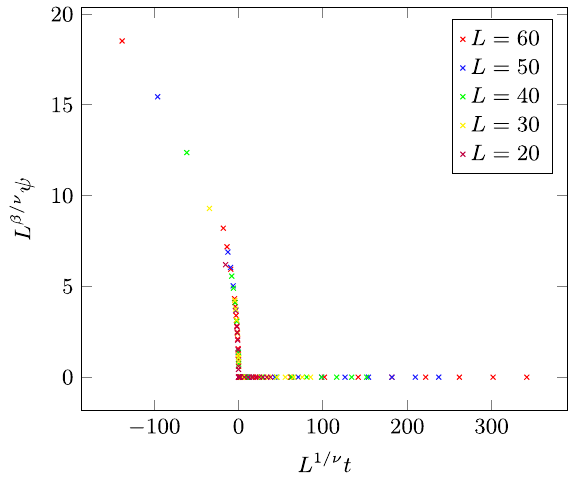
FIG. 16. Example obtaining T from fits without finite-size c FIG. 15. The rescaled order parameter plotted against reduced scaling for U ¼ − 4 t , t ⊥ ¼ 0 . 4 t , n ¼ 0 . 5 . Symbols denote the on- =T temperature t ¼ ð T − T for U ¼ − 10 t , t ⊥ ¼ 0 . 3 t , and site order parameter extrapolated to infinite number of iterations c c Þ n ¼ 0 . 5 . The critical temperature is obtained by minimizing for L ¼ 20 (plus), L ¼ 50 (cross), and L ¼ 60 (star) computed Eq. (A7). via MPS þ MF for thermal states. Solid lines are guides to the eye. Dashed lines are fits with ansatz Eq. (A8). Inset shows an example of extrapolating the order parameter to infinite numbers of iterations for L ¼ 50